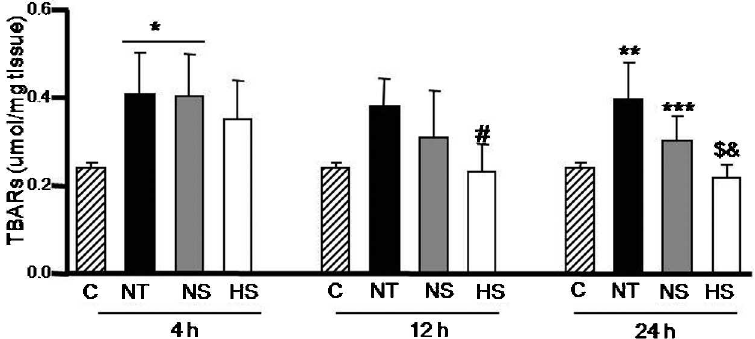
Figure 3 - Effect of hypertonic saline on hepatic lipid peroxidation. Thiobarbituric acid reactive substances (TBARS) in tissue homogenates of rats in the control (C), NS, HS, and NT groups. Data are means ¡ SEM, n = 8 in each group. * P , 0.05 vs. C; # P , 0.05 vs.